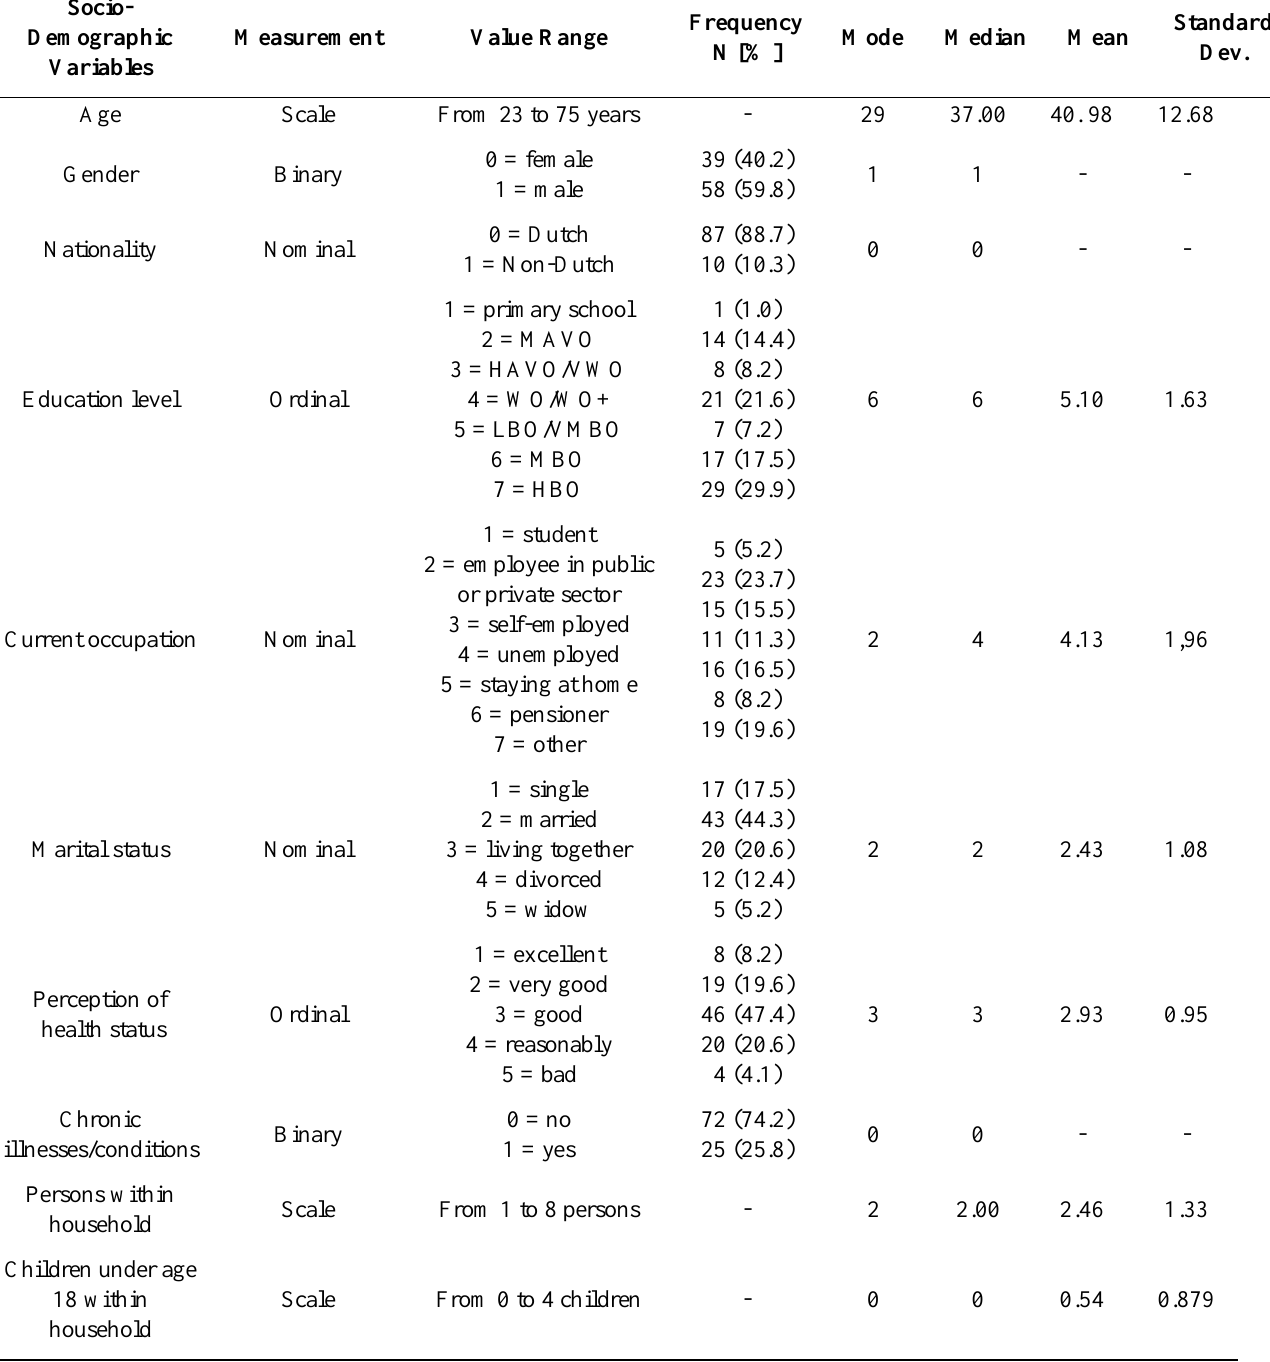
Table 3. Socio-demographic features of the